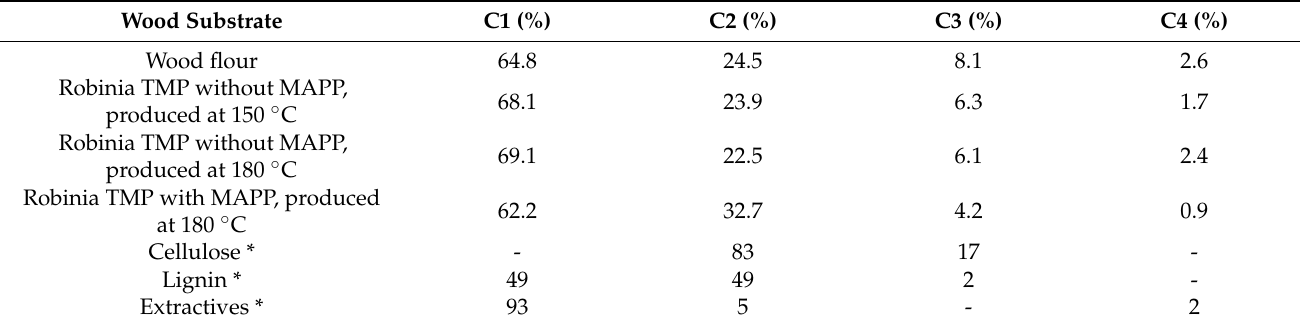
Table 4. Results of the C1s high resolution spectra